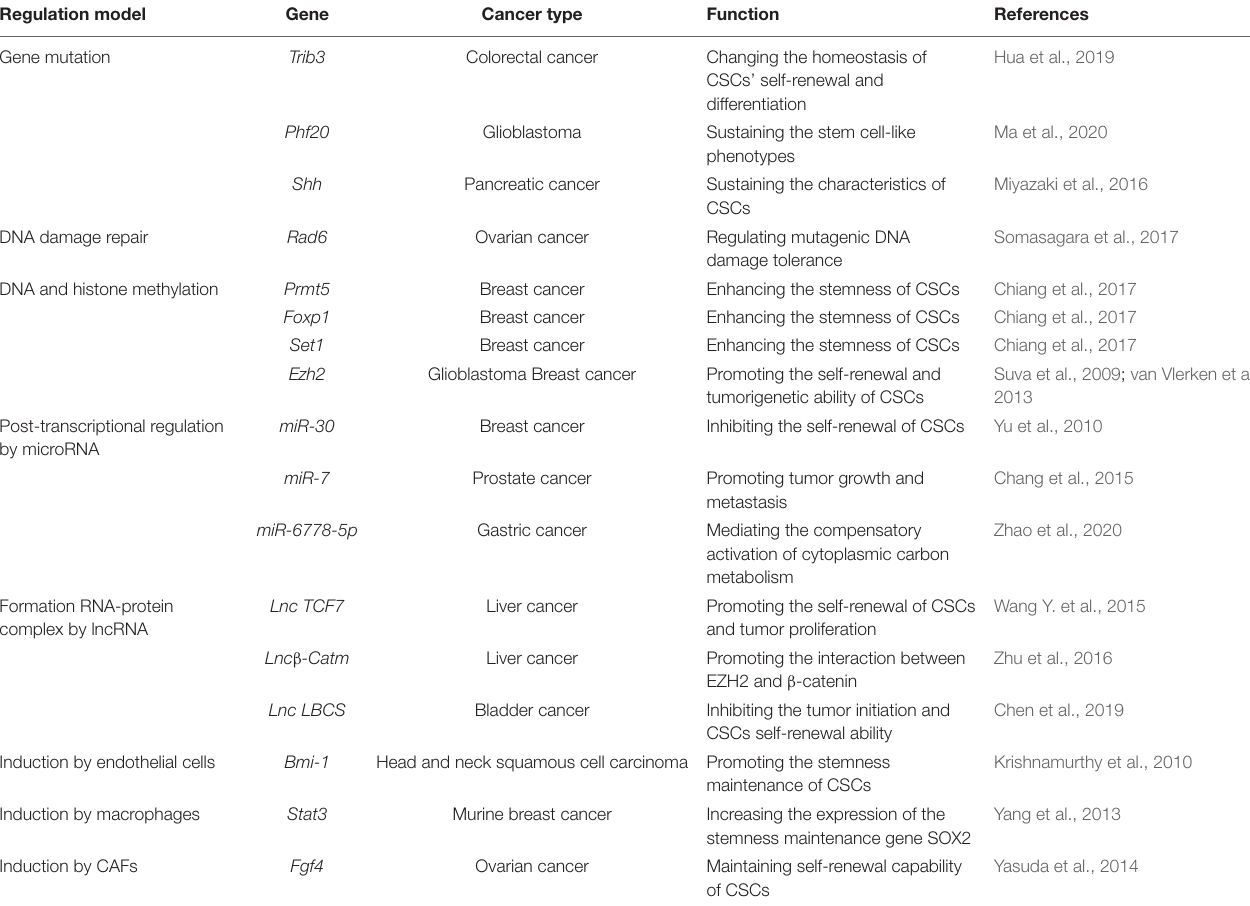
TABLE 2 | Genes involved in the stemness maintenance of